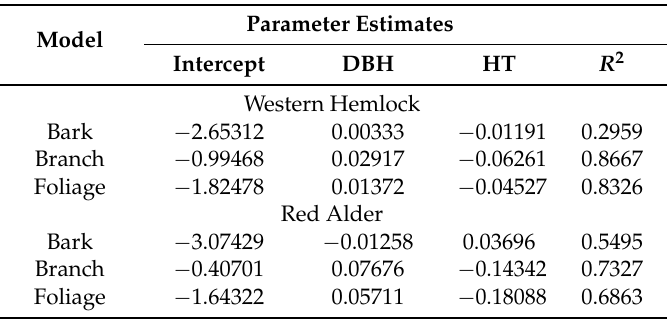
Table 9. Parameter estimates for the component biomass models for Western hemlock and red alder trees using multinomial log-linear regression model. Component bole was used as reference group for both species.